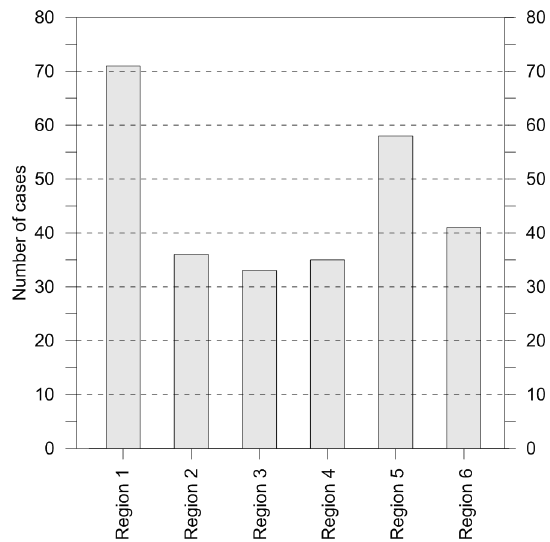
Figure 3. Number of years with droughts in six geographical re- gions of Poland (including information related to the whole coun- try) 1451–1800. See Table 2 or Fig. 4 for the names of